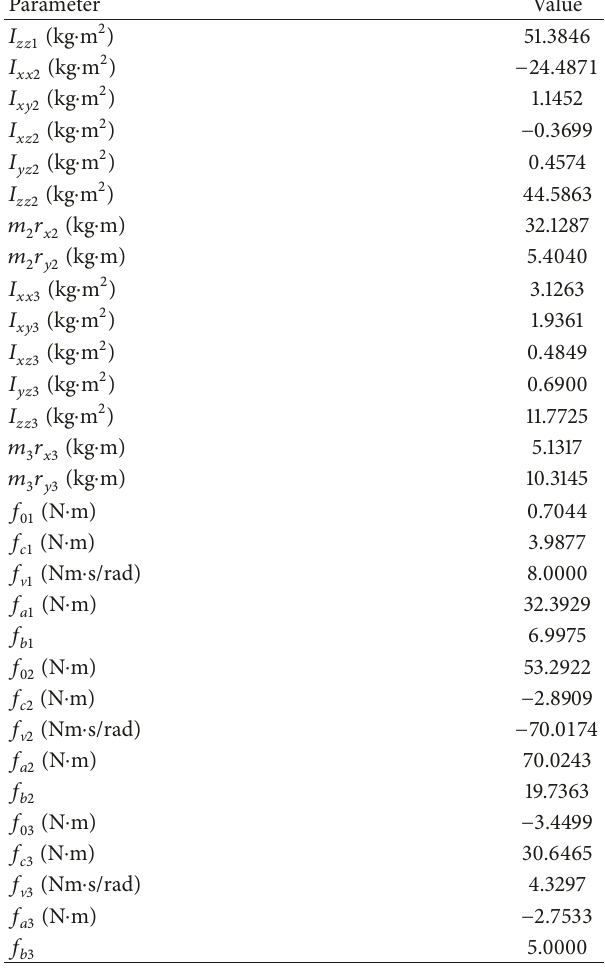
Figure 4: 3D excitation trajectory in work space.